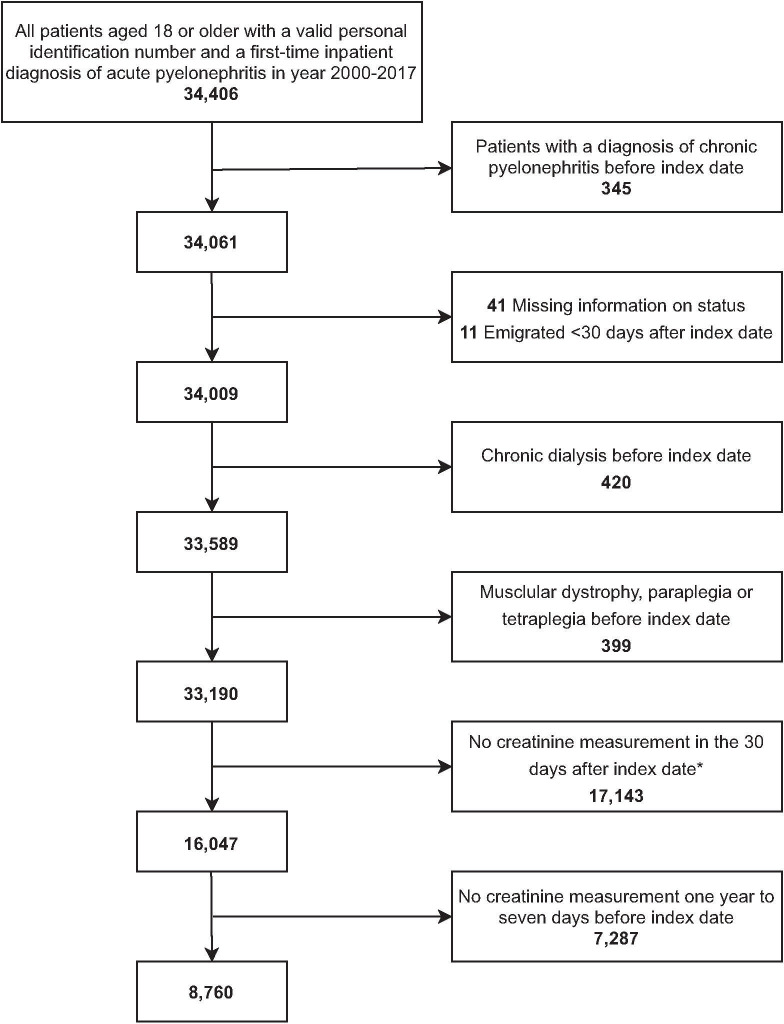
Flowchart of patient inclusion and exclusions.*Patients not covered by the laboratory databases.